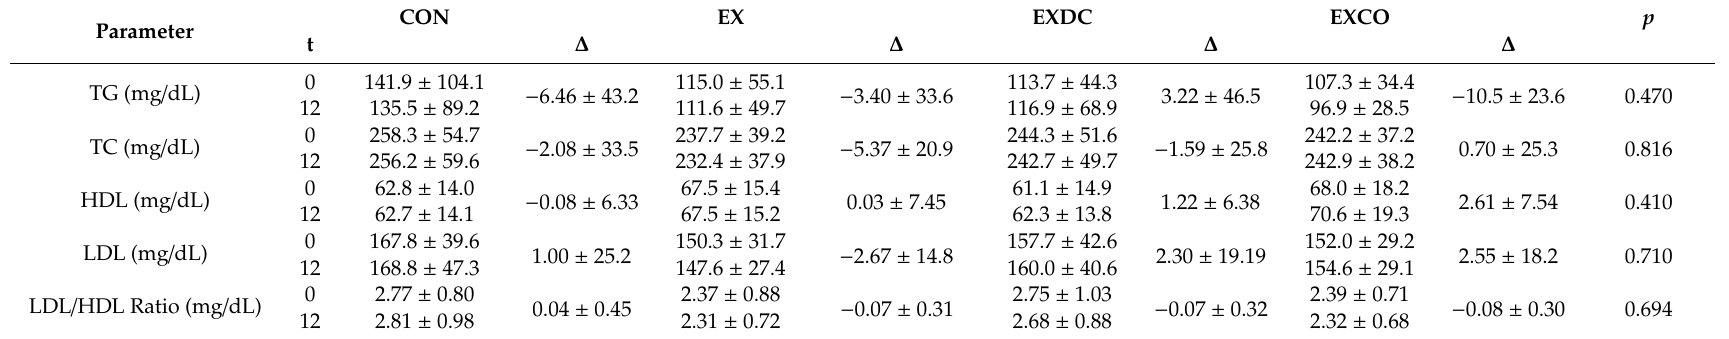
Table 6. Blood lipids and absolute changes ( ∆ ) of the four groups at the beginning (0) and at the end (12) of the intervention.